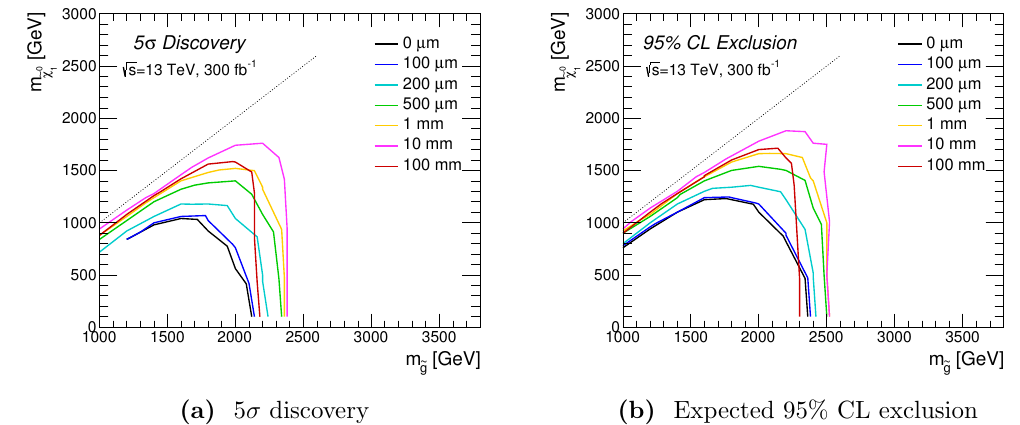
Figure 12. Same as in (cid:12)gure 11, but for an integrated luminosity of 300 fb (cid:0) 1 .